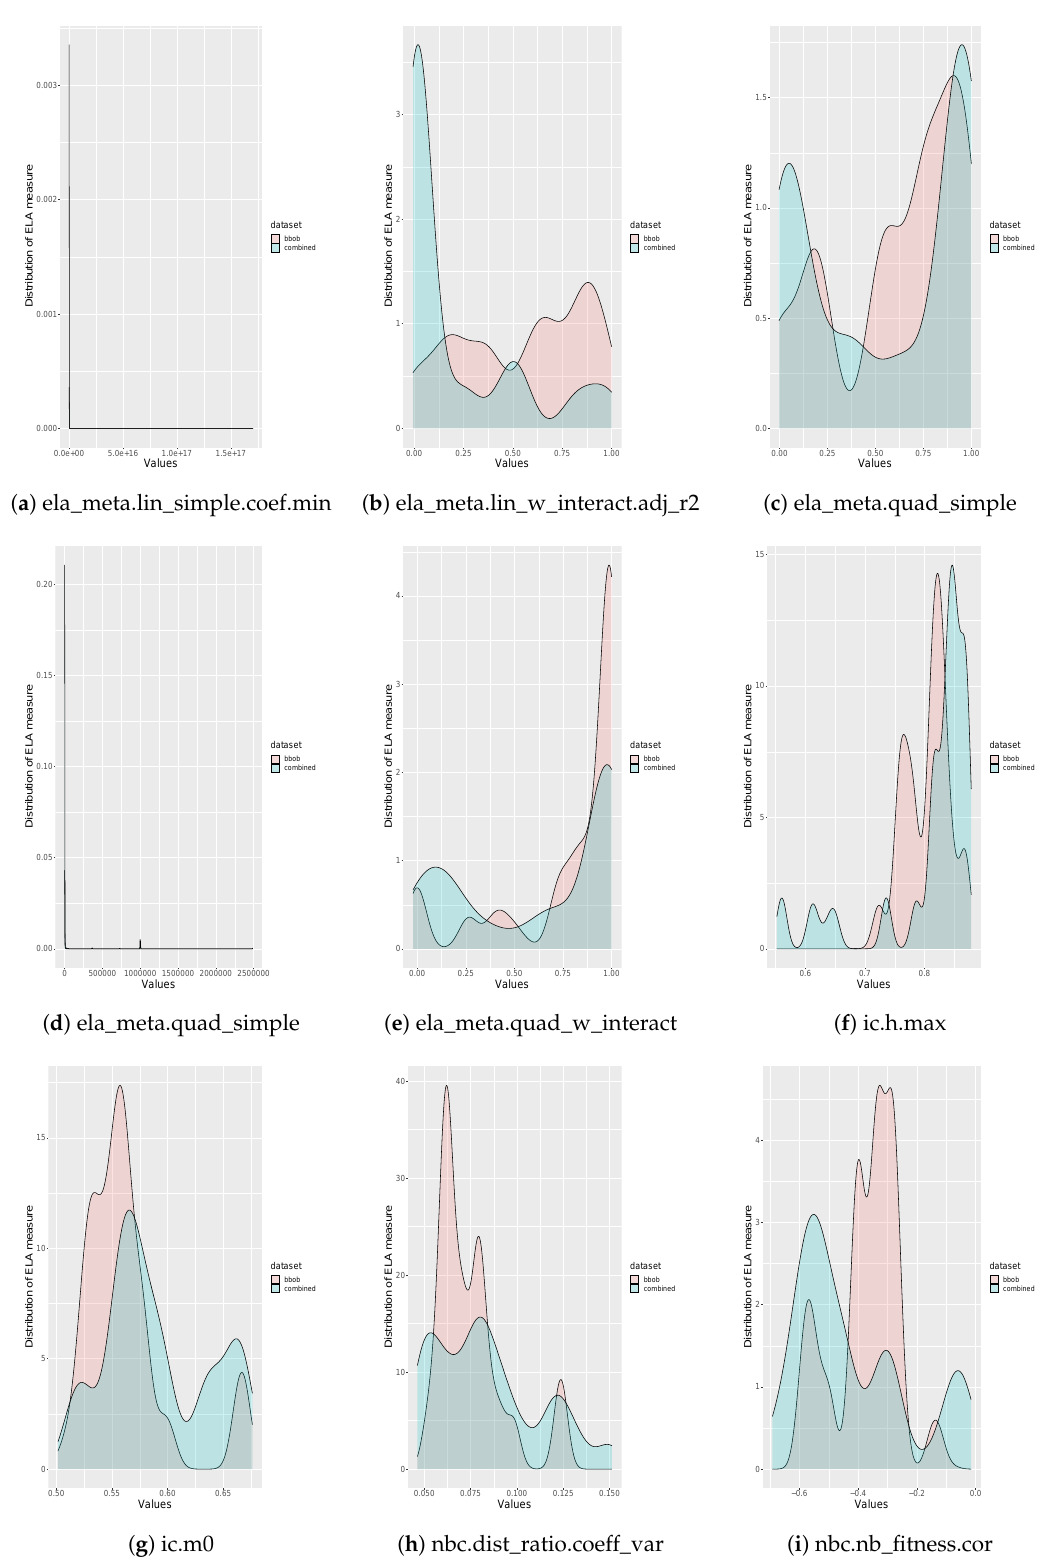
Figure 9. Comparison of the distributions of the BBOB benchmark suite and the proposed benchmark suite for all of the ELA measures used as input to the SOM